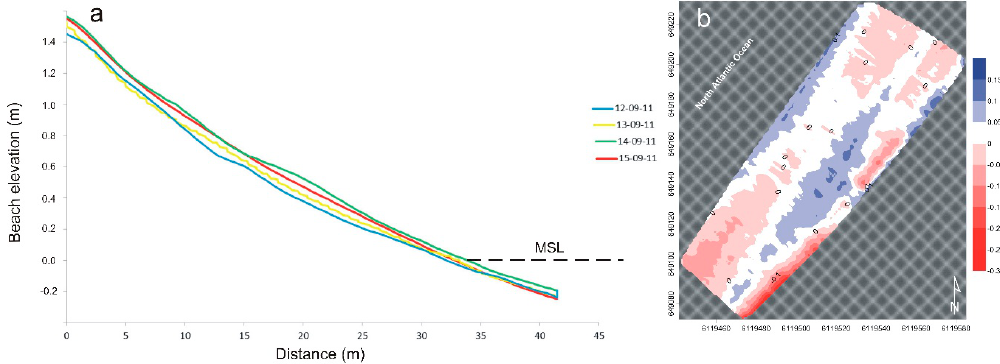
Figure 6. ( a ) Profile 2 evolution and ( b ) 3D morphological changes at Portrush Southern Sector.